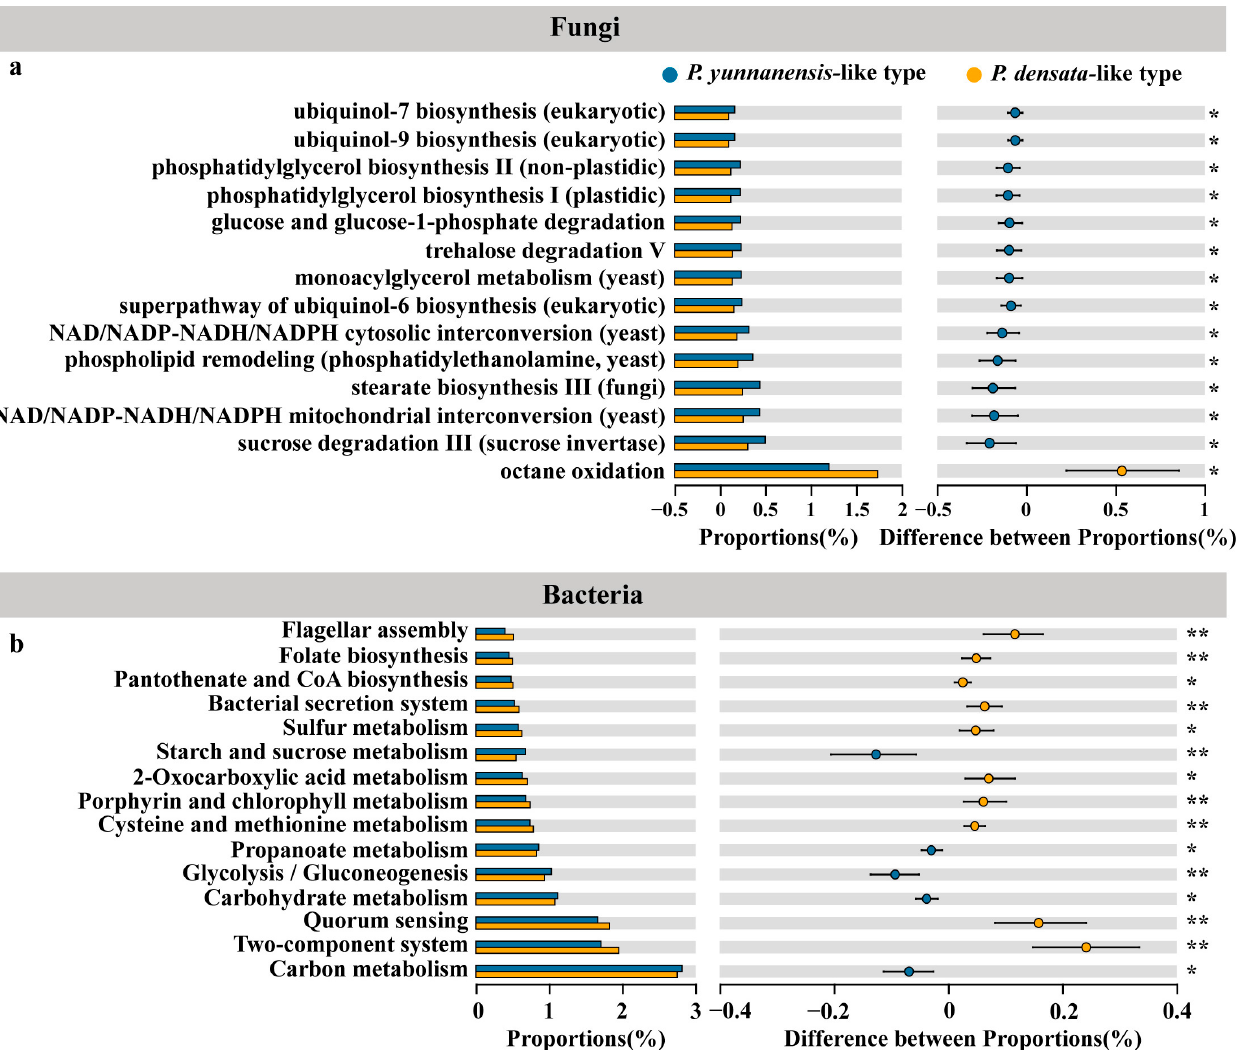
Figure 6. Differentiation of predicted KEGG or MetaCyc functions between the P. yunnanensis -like type and P. densata -like type. The different fungal ( a ) and bacterial ( b ) functions between the P. yunnanensis -like type and P. densata -like type predicted by PICRUSt2. Mann–Whitney U tests were used to evaluate differences in the abundance of pine root endophytes. Significant difference: * p ≤ 0.05, ** p ≤ 0.01.